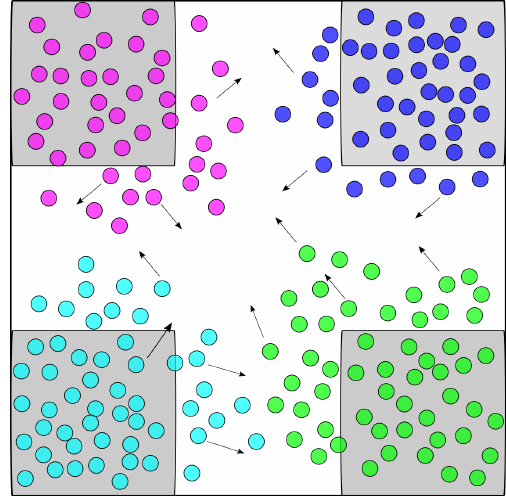
Figure 5. Reverse process in each